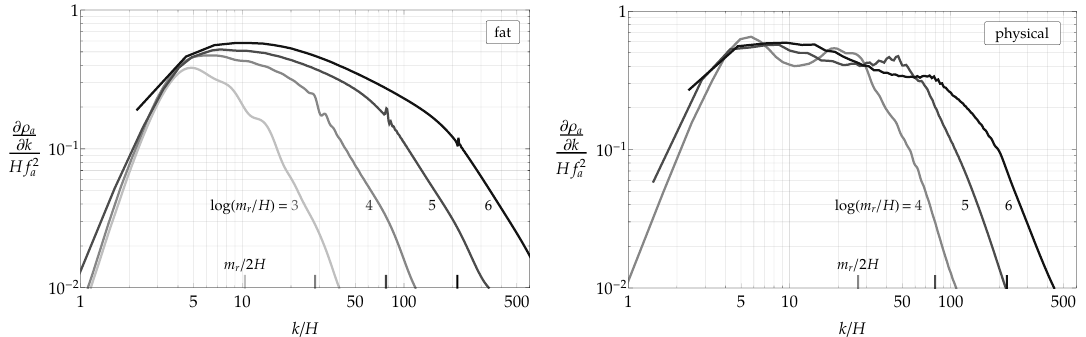
Figure 10 . The axion energy density spectrum @(cid:26) a =@k as a function of the ratio of the physical momentum k to the Hubble parameter. The results are shown for di(cid:11)erent times (i.e. di(cid:11)erent values of log( m r =H )) for a string system in the scaling regime, in the fat string (left) and the physical (right) scenarios. In both cases the spectrum is dominated by a broad peak at around k=H = 10, and emission at lower momenta is suppressed. As a reference, for each time shot we also show the